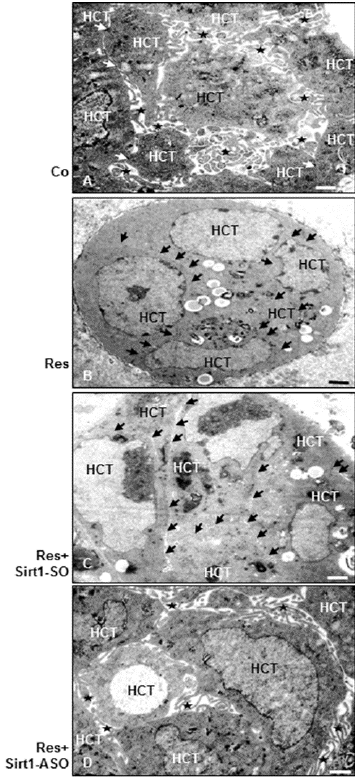
Figure 8. Transmission electron microscopic investigation of cell-phenotype behavior in CRC cells in alginate beads after treatment with resveratrol or/and ASO against Sirt1. Serum-starved HCT116 cells in alginate culture (1 × 10 6 /mL) were either left untreated ( A ), or treated with resveratrol alone (5 μ M) ( B ), or transfected with 0.5 µ M sense oligonucleotide (SO) control ( C ), or antisense oligonucleotides (ASO) against Sirt1 ( D ) in the presence of Lipofectin transfection reagent (10 µ L/mL) and co-treated with resveratrol (5 µ M) for 14 days. After 14 days of culture, transmission electron microscopic observations of HCT116 cells in alginate showed in control cultures tumor cells with a planar surface and microvilli (*) on their surface ( A ). Treatment with resveratrol alone or co-treated tumor cells (HCT116) with resveratrol and control-SO showed only a few microvilli, but they had contact planar surface (arrows) ( B , C ). Sirt1-ASO- and resveratrol co-treated tumor cells contained abundant microvilli on their surface ( D ). Scale bar = 1 μ m.